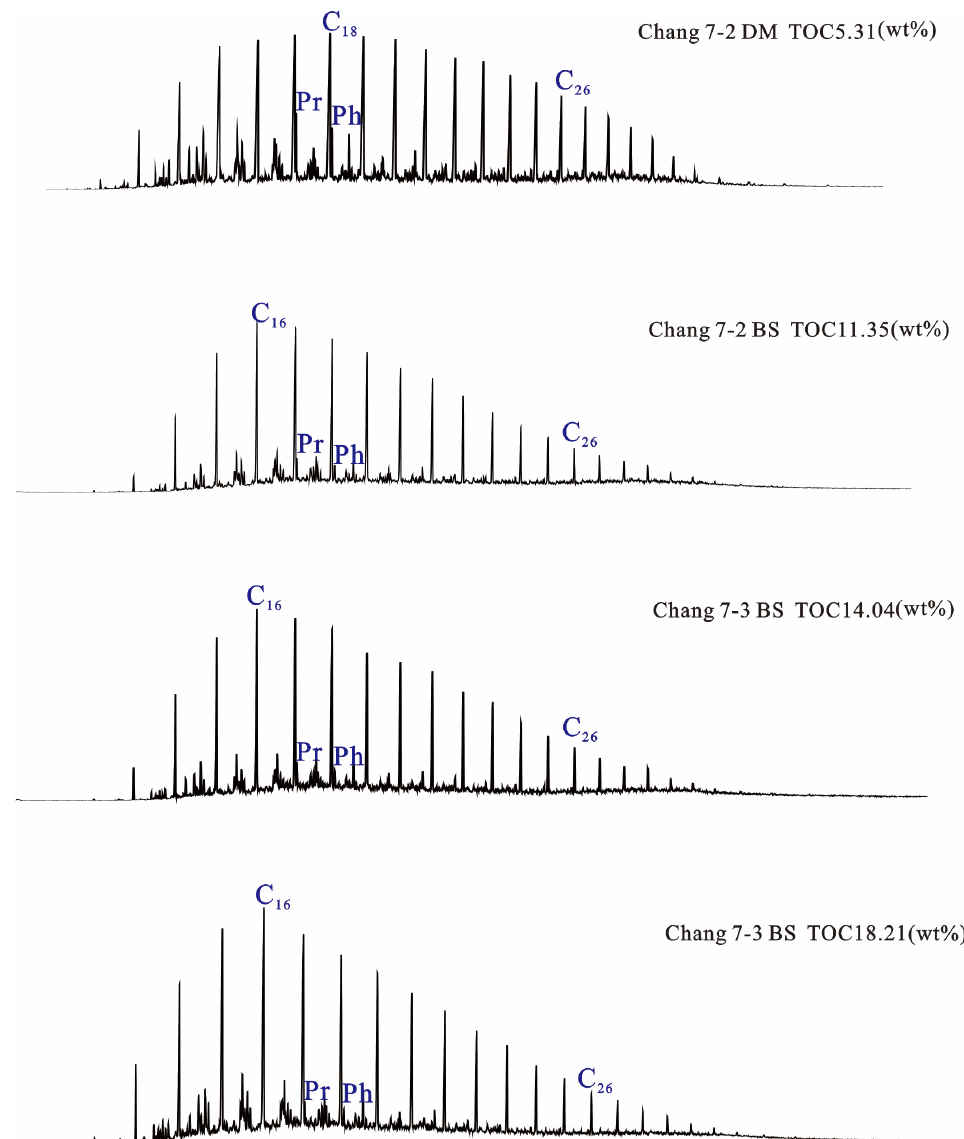
Figure 5. Total ion current gas chromatograms of saturated hydrocarbon fractions for partial sam- ples. Table 2. Biomarker ratios for the source rock samples.